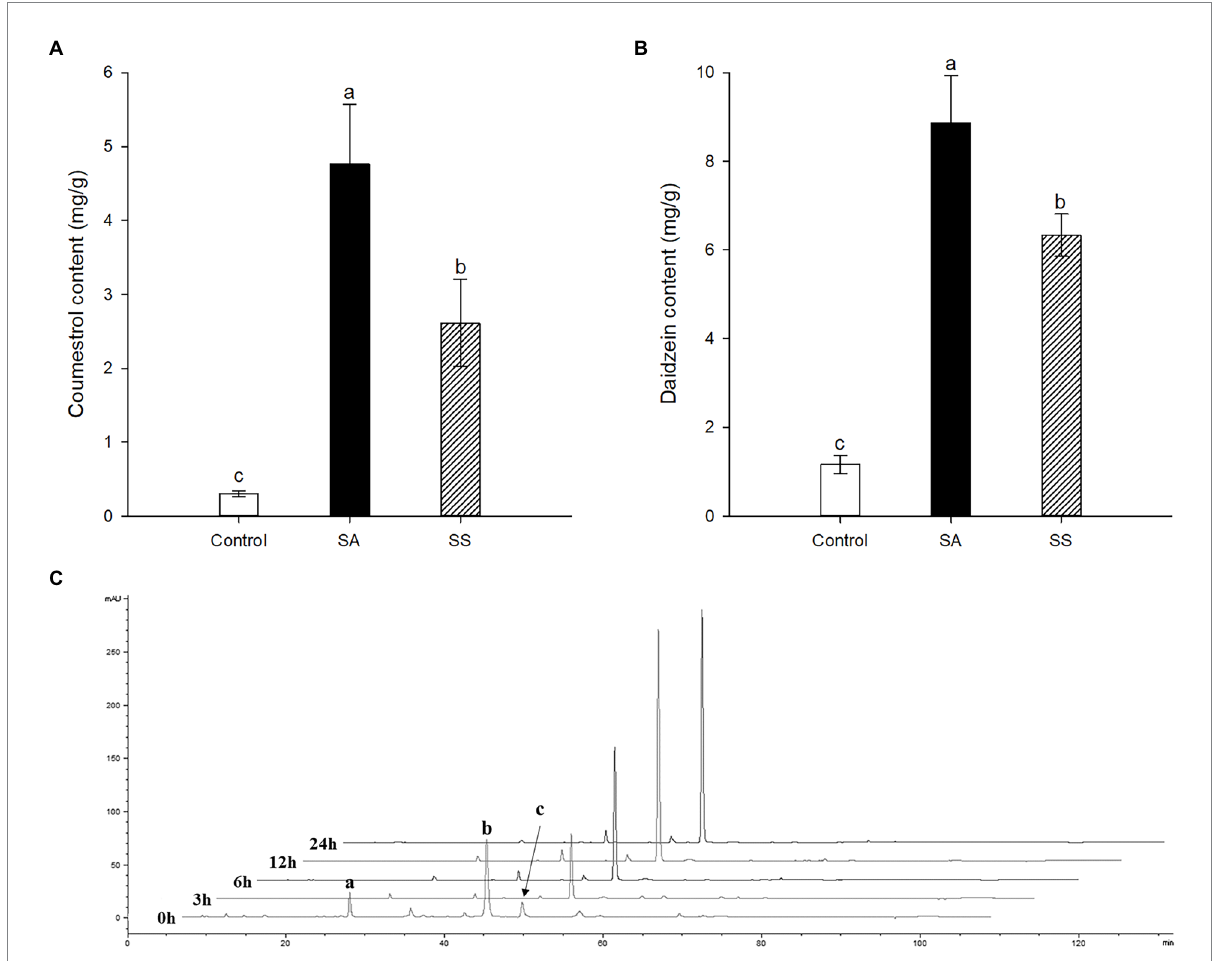
FIGURE 3 (A) Comparison of coumestrol contents between SA and sodium salicylate (SS) treatments. (B) Comparison of daidzein contents between SA and SS treatments. (C) Changes in HPLC chromatographic patterns by treatment time of SA at 340 nm. Peak a, coumestrin; peak b, malonylcoumestrin; peak c, coumestrol. Data are the mean ± SD of determinations performed in five replicates in 5 samples. Different letters indicate significant differences, as determined by Tukey’s (LSD) test with p <